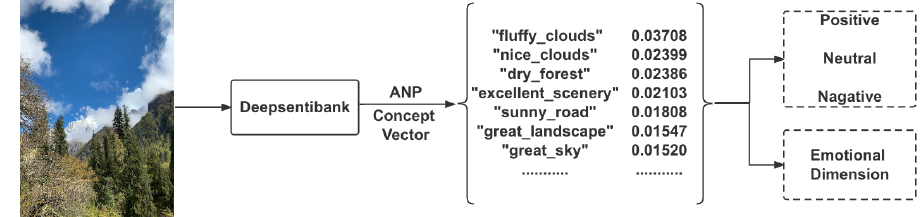
Figure 6. The process of photos analyzed by Deepsentibank.